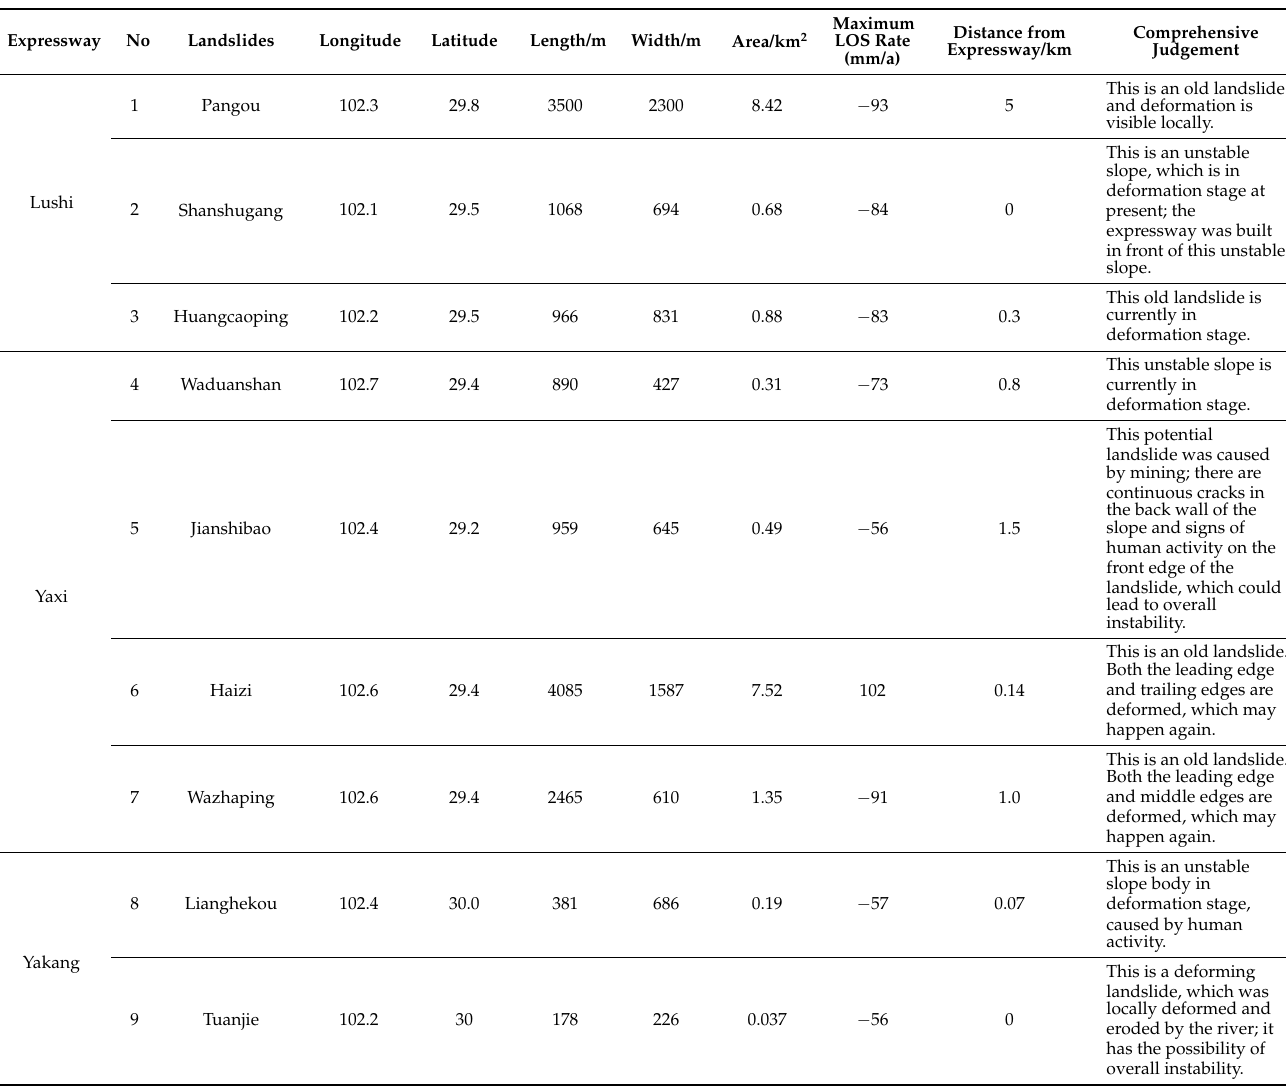
Table 3. Statistics of nine detected landslides with potential risks to